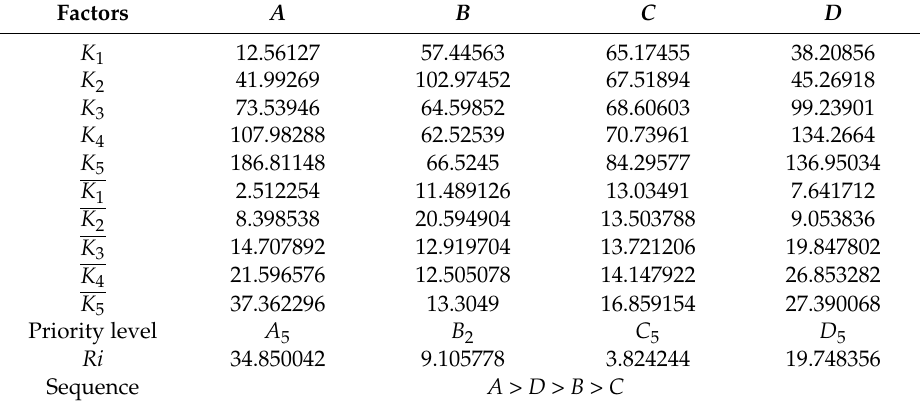
Table 3. Index average and range analysis table of heat convection performance in the microchannel.